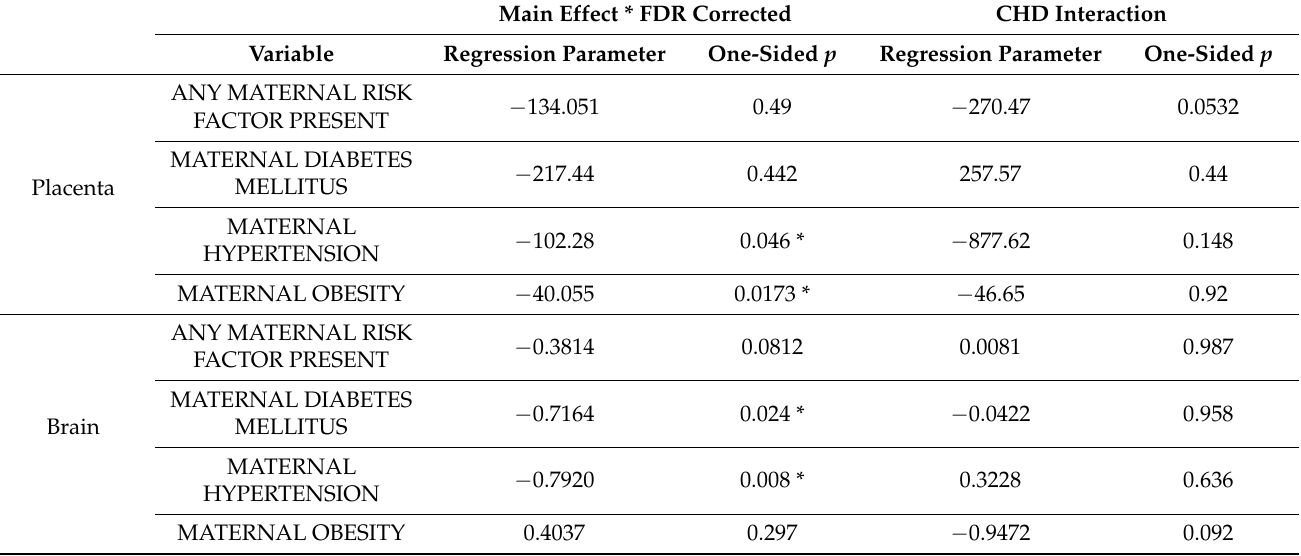
Table 5. : Association between Maternal Risk Factors (MRF) and Spatial Variance in CHD and Non-CHD